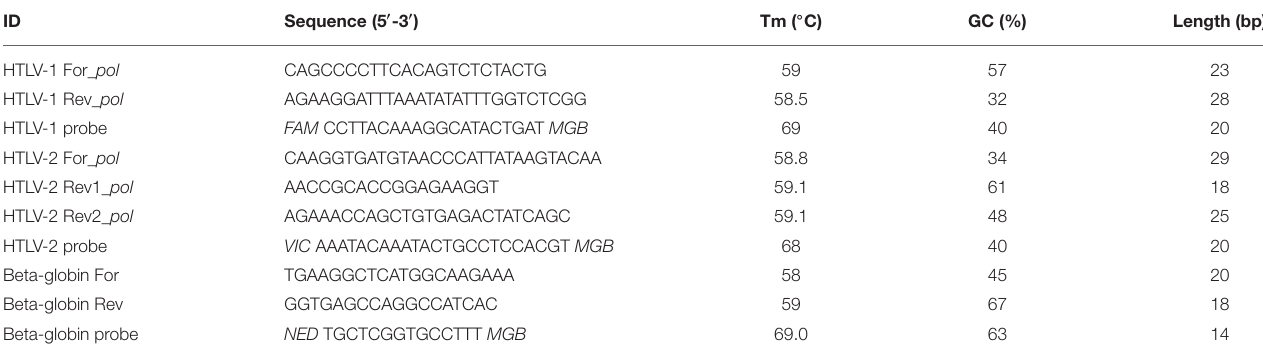
TABLE 1 | Primers and probes sequences for HTLV-1, HTLV-2, and beta-globin (internal amplification control)